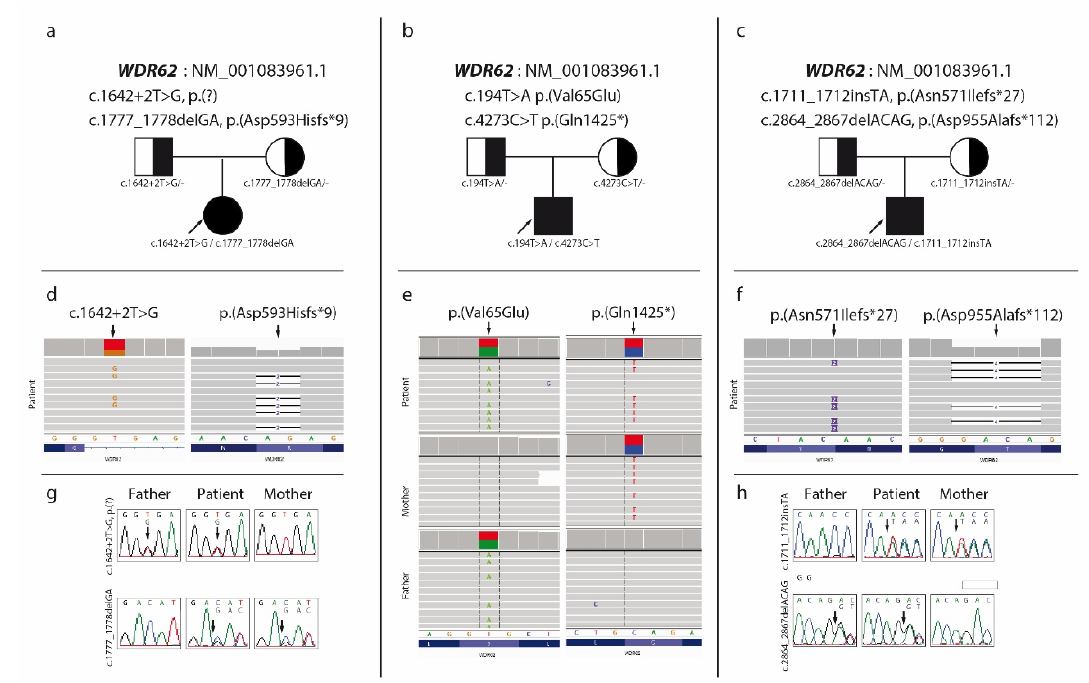
Figure 2. Pedigree ( a – c ), the Integrative Genomics Viewer (IGV) from Whole Exome Sequencing ( d , f ), IGV from Amplicon Deep Sequencing ( e ) and Sanger sequencing plots ( g , h ) showing segregation of the variants in WDR62 in case 1 ( a , d , g ), case 2 ( b , e ) and case 3 ( c , f , h ). The proband is indicated with an arrow.